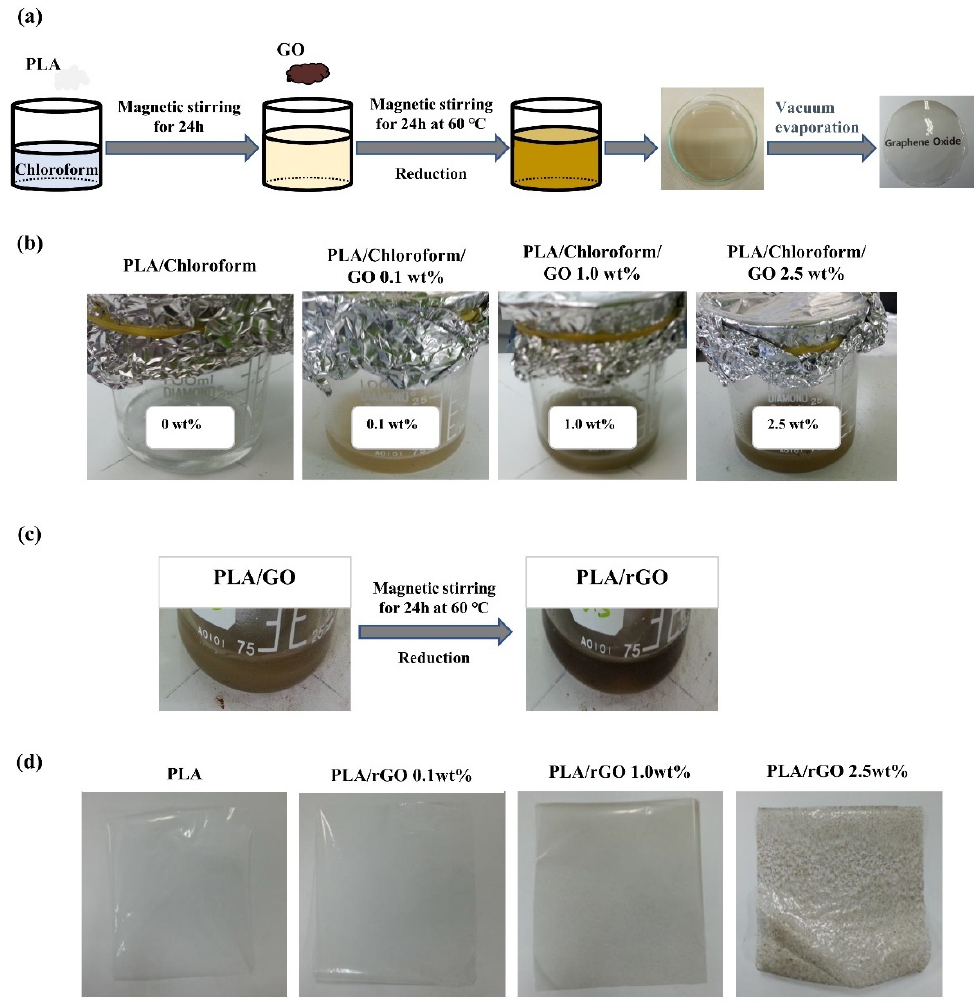
Figure 2. PLA/rGO films prepared by solvent casting: ( a ) schematic illustration of the sample preparation; ( b ) PLA/GO solutions with different GO concentrations; ( c ) color change of PLA/GO solution before and after reduction; and ( d ) PLA/rGO film samples with different rGO concentrations.